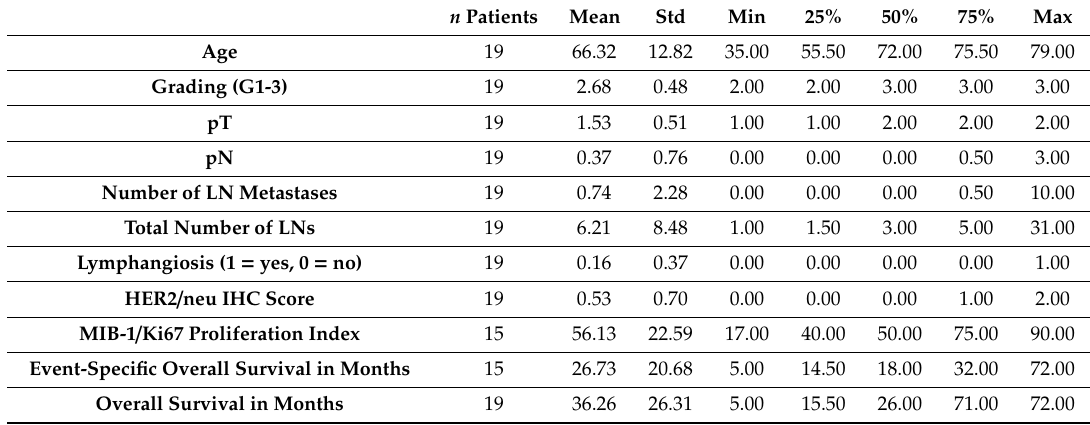
Table 1. Descriptive statistic of patients’ characteristics.